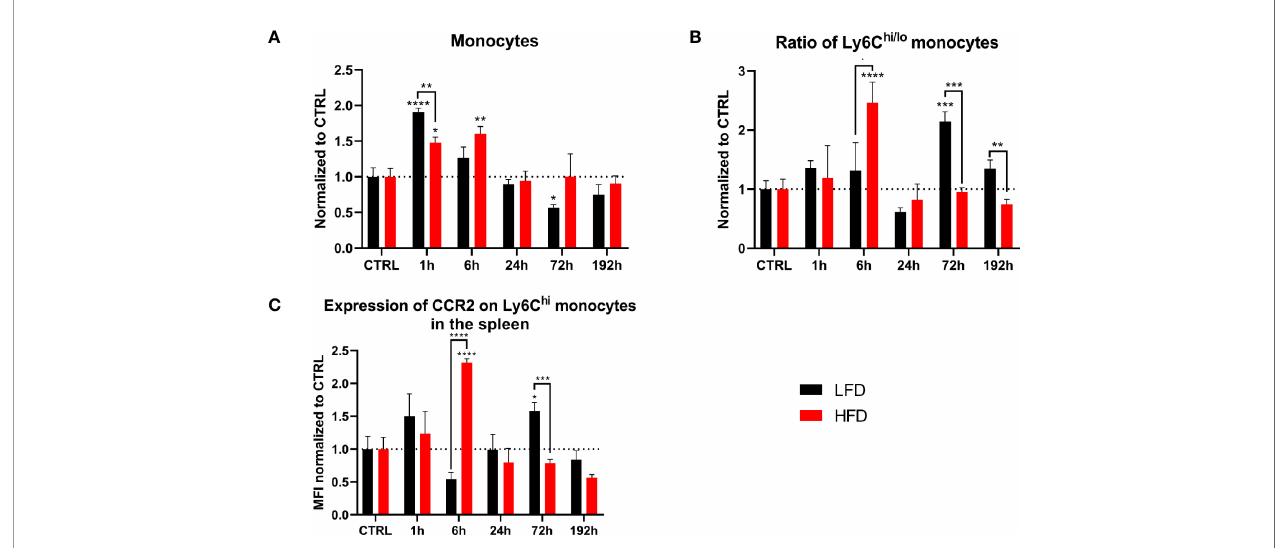
FIGURE 3 | Myeloid cells in the spleen during the fi rst 192 h analyzed by fl ow cytometry. Baseline-corrected (ratio) timelapse for monocytes (A) , the ratio of Ly6C hi/lo monocytes (B) , and the expression of CCR2 on Ly6C hi monocytes depicted as mean fl uorescence intensity (MFI) (C) . Statistics: two-way ANOVA with an uncorrected Fisher ’ s LSD test as follow-up was used to compare the level to the respective CTRL, signi fi cance indicators are displayed directly above the bar; unpaired two-tailed Student ’ s t -test was used for comparison of lean and obese mice at a speci fi c time point, signi fi cance indicators are displayed above a connector line. ▪ indicates p ≤ 0.1, * indicates p ≤ 0.05, ** indicates p ≤ 0.01, *** indicates p ≤ 0.001, **** indicates p ≤ 0.0001. Sample sizes: LFD CTRL = 13, LFD 1 h = 6, LFD 6 h = 5, LFD 24 h = 5, LFD 72 h = 6, LFD 192 h = 6, HFD CTRL = 14, HFD 1 h = 5, HFD 6 h = 5, HFD 24 h = 7, HFD 72 h = 5, HFD 192 h = 8. Data are displayed as mean ±